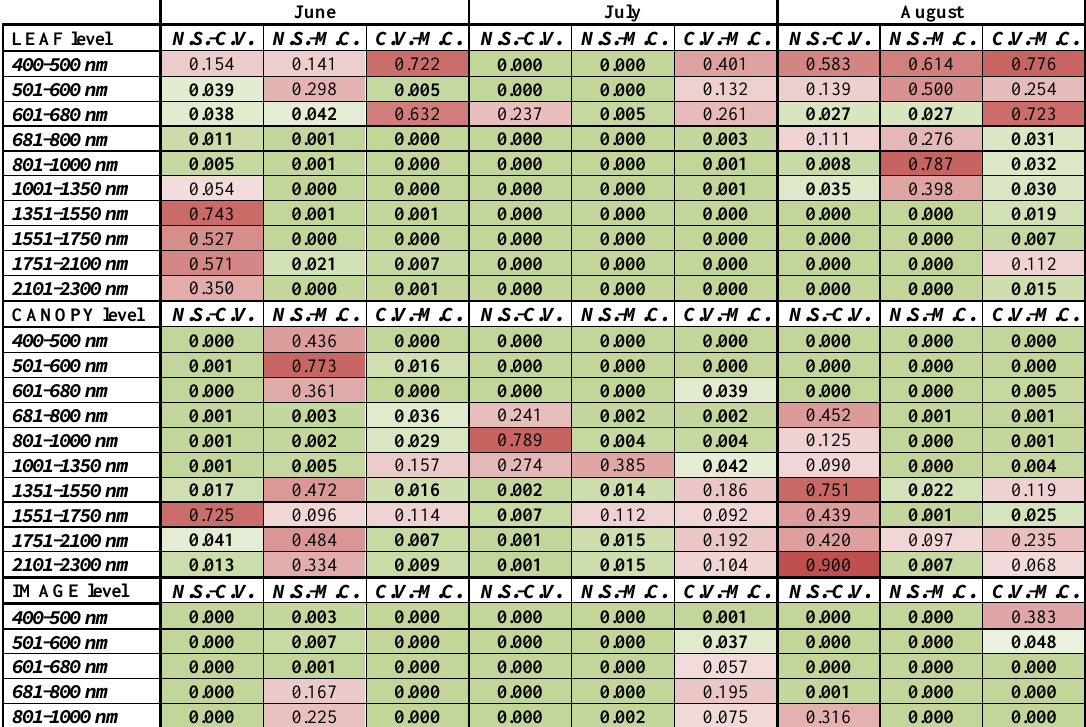
Table 1. Median p-values of Welch's (unpaired) t-test for each species ( C.V. – Calamagrostis villosa, M.C. – Molinia caerulea, N.S. – Nardus stricta ), spectral measurement method and date for selected spectral intervals. P-value < 0.05 means that significant difference between species exists (green scale); non-separable intervals of the wavelengths are indicated in red